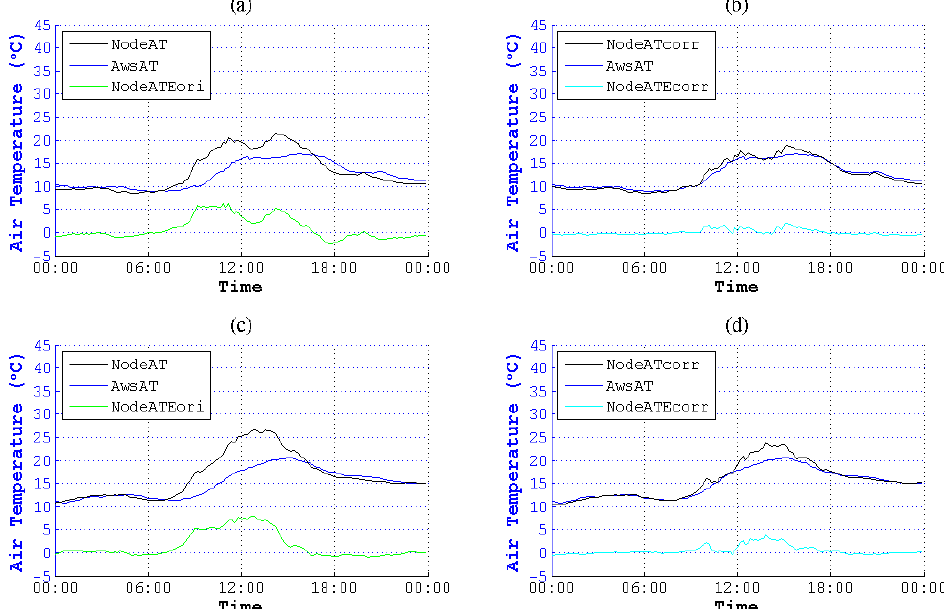
Figure 16. Contrast of NodeAT and NodeATcorr on 11 November 2014 and 22 November 2014. ( a ) Original data on 11 November 2014; ( b ) corrected data on 11 November 2014; ( c ) original data on 22 November 2014; ( d ) corrected data on 22 November